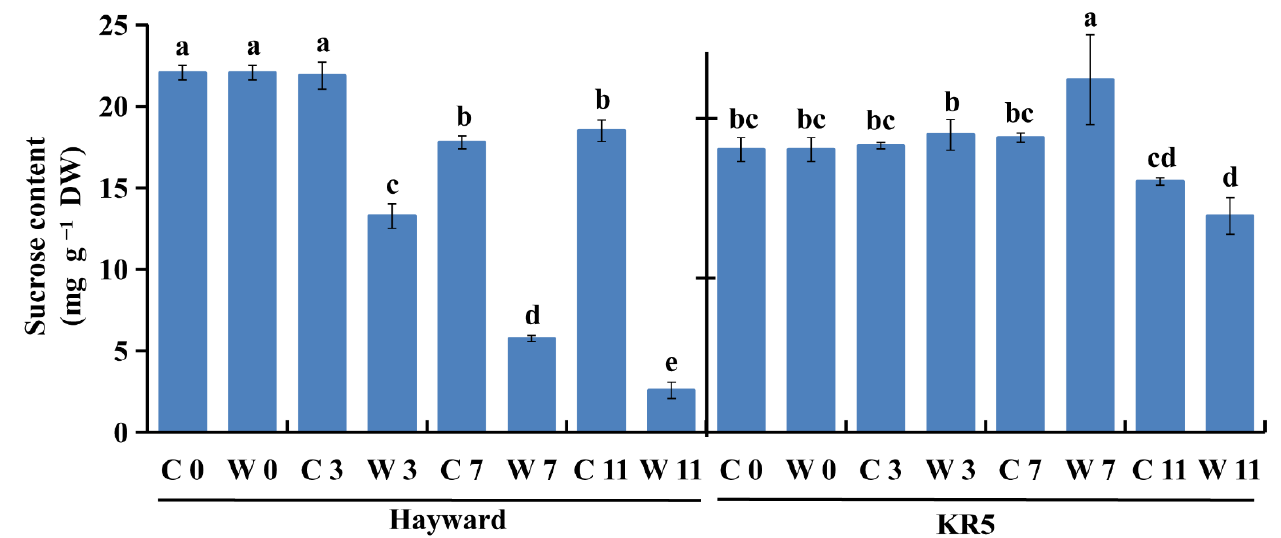
Figure 5. Sucrose contents of ‘Hayward’ and KR5 plants under control or waterlogging conditions. DW, dry weight. C 0, C 3, C 7, and C 11 indicate 0, 3, 7, and 11-d controls, respectively. W 0, W 3, W 7, and W 11 indicate waterlogging treatments of 0, 3, 7, and 11 d, respectively. Values are the mean ± SD ( n = 3). Significant differences between treatments per genotype at p < 0.05 are indicated by different letters over columns (Duncan’s test).